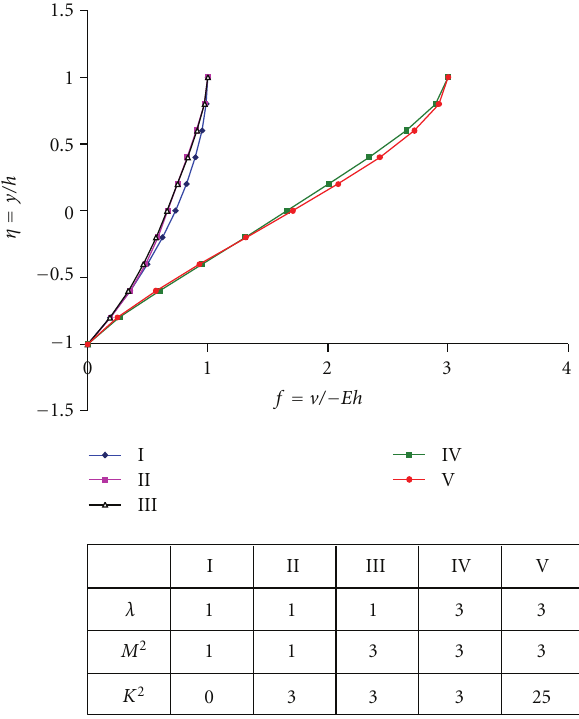
Figure 2: Velocity profile for (cid:7) R (cid:6) 0 . 1 ,N (cid:6) 10 (cid:8)